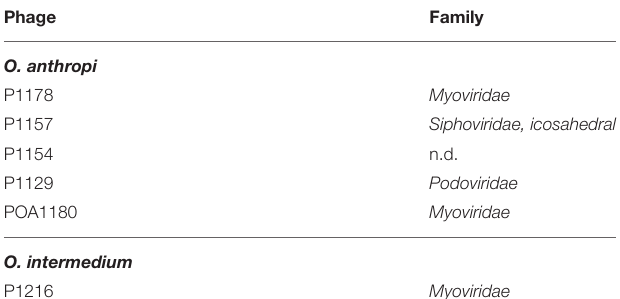
TABLE 3 | Spontaneous lysis of Ochrobactrum spp. strains. Ochrobactrum spp. strain